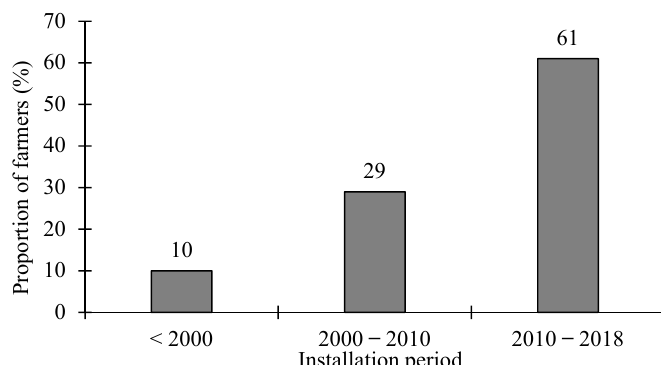
Figure 11 . Period of installation of migrant cocoa farmers in Biankouma region .